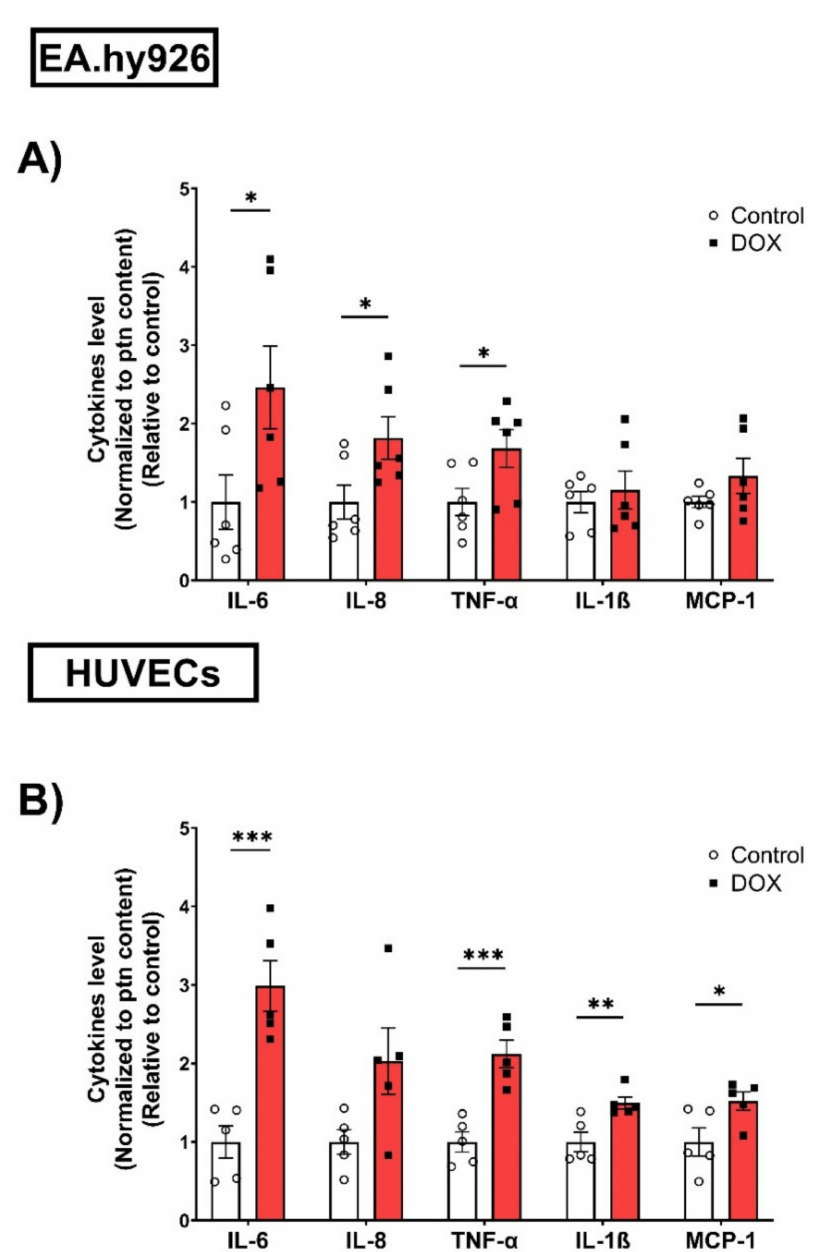
Figure 4. DOX induces the protein expression of SASP factors in conditioned media of EA.hy926 cells and HUVECs. EA.hy926 human-endothelial-derived cells and HUVECs were treated with DOX (0.5 µ M) for 24 h. Thereafter, DOX was removed and cells were incubated with DOX-free media for 72 h. Conditioned media were collected and the expression of SASP factors including IL-6, TNF- α , IL-8, IL-1B, and MCP-1 in ( A ) EA.hy926 cells ( n = 6) and ( B ) HUVECs ( n = 5) was determined by Luminex. Values were normalized to the protein (ptn) content of the cells determined by BCA and the results are expressed as the fold expression relative to control cells. Values are shown as means ± SEM. Data were analyzed by unpaired two-tailed t-test. Note: * p < 0.05, ** p < 0.01, *** p <